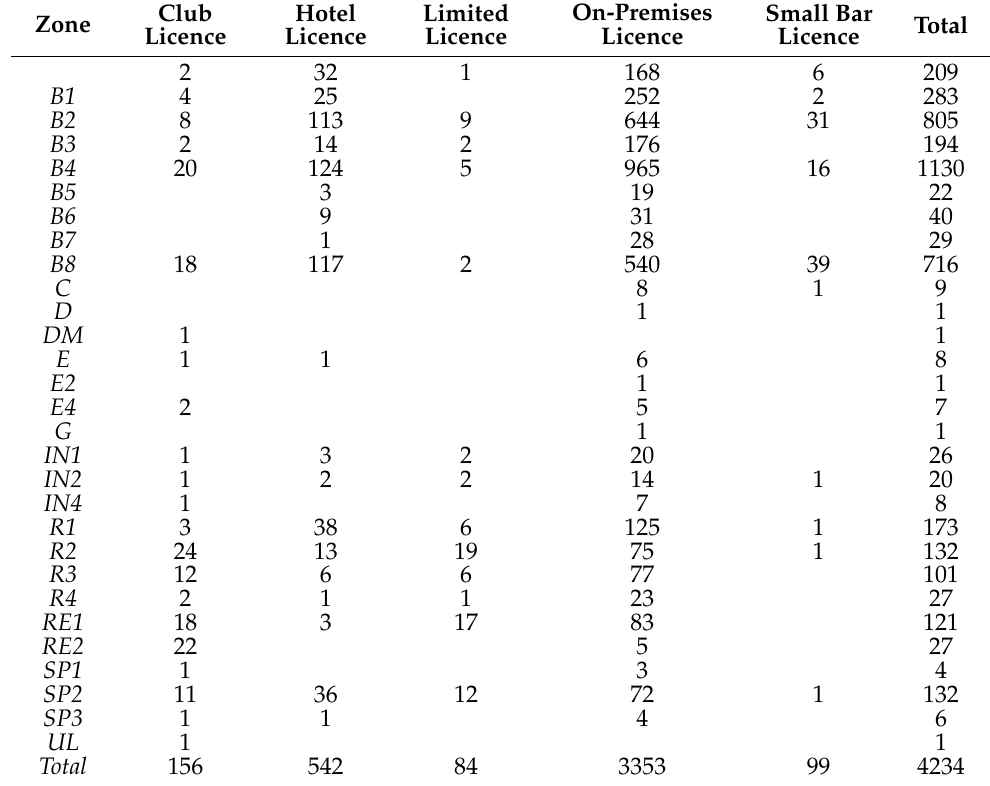
Figure 7. Number of venues per land zone. Table 2. Licensed venues per land use